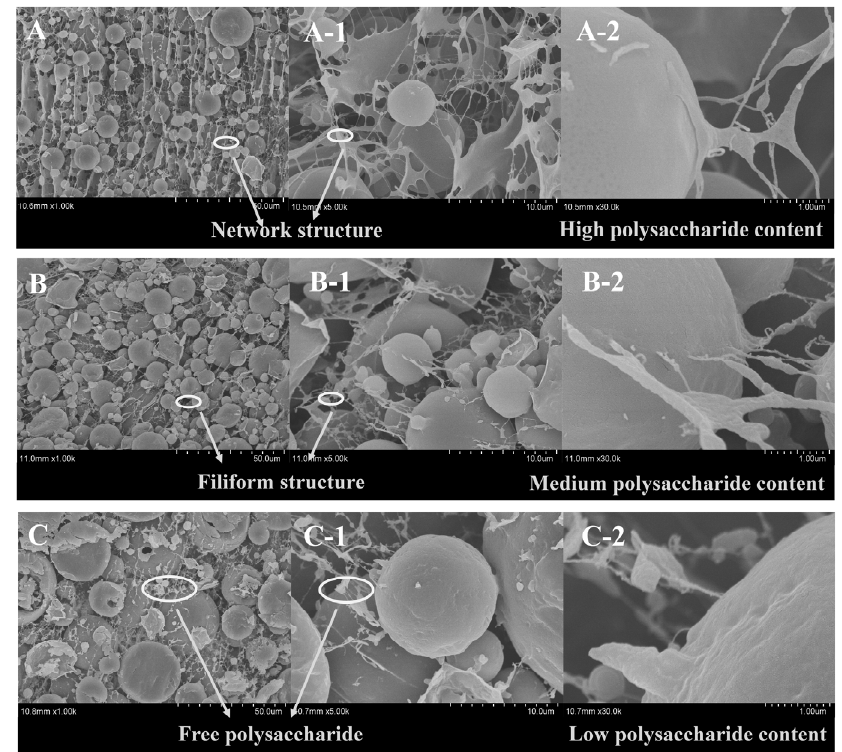
Figure 6. Cryo-SEM images of emulsions stabilized by fraction 1, fraction 2, and fraction 5 ( A – C , ×1000; A-1, B-1, and C-1, ×5000; A-2, B-2, and C-2, ×30,000).